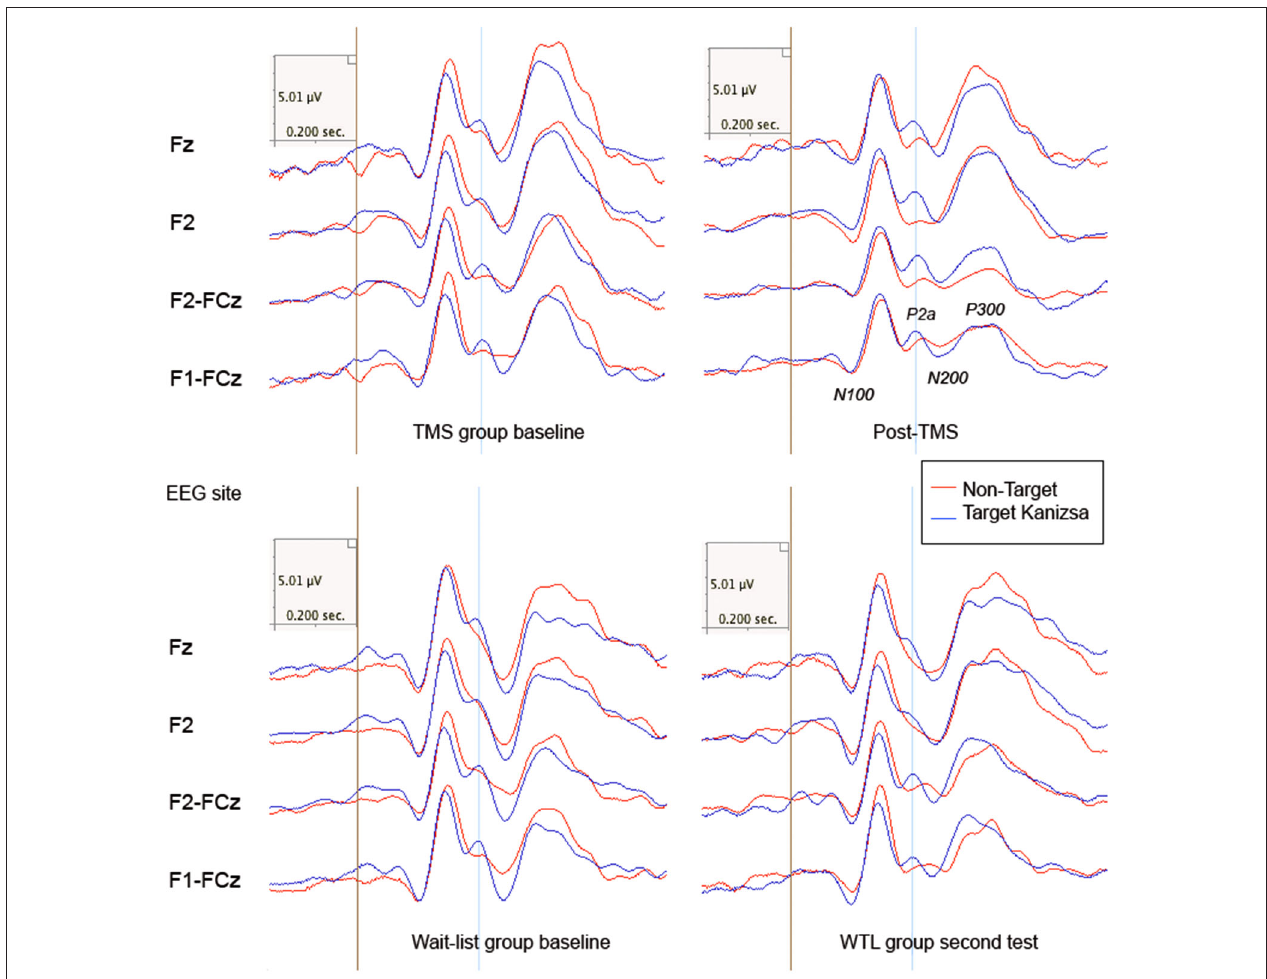
FIGURE 4 | Frontal and frono-central ERPs (Fz, F2, F2-FCz, F1-FCz) to target and non-target Kanizsa figures in TMS and wait-list groups ( N = 27/per group) before and after treatment (TMS/ or wait-period). Frontal P2a components (280–320 ms post stimulus) is marked with a blue